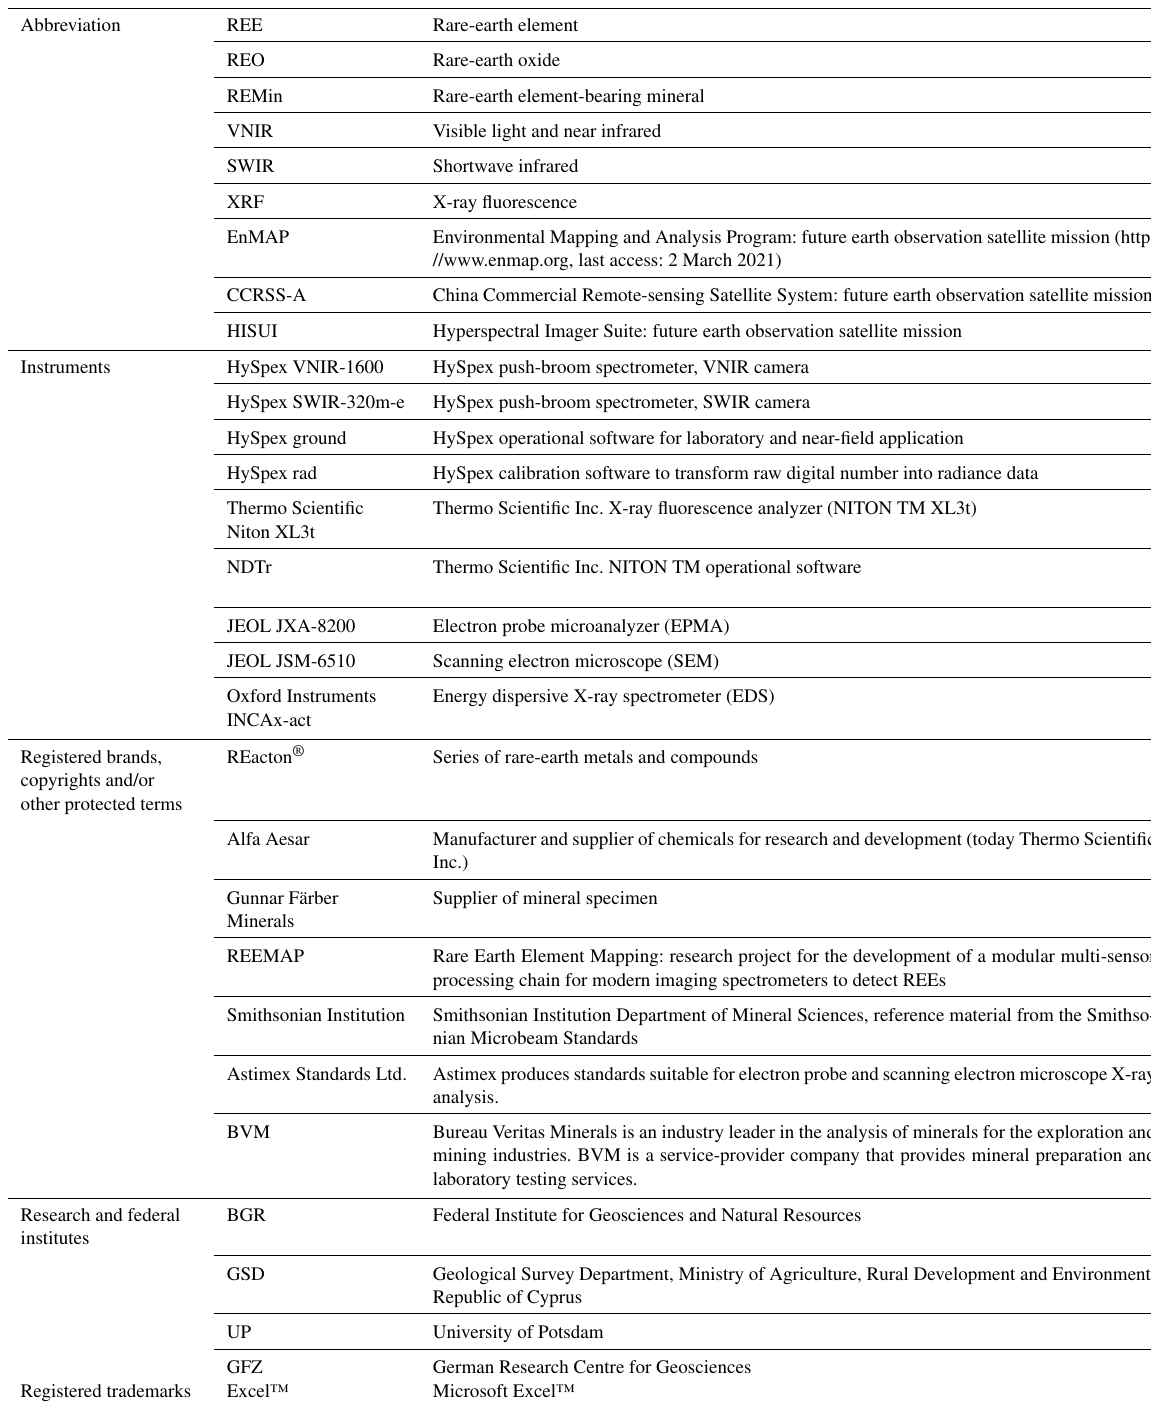
Table A1. List of less commonly known terms and their abbreviations used throughout the